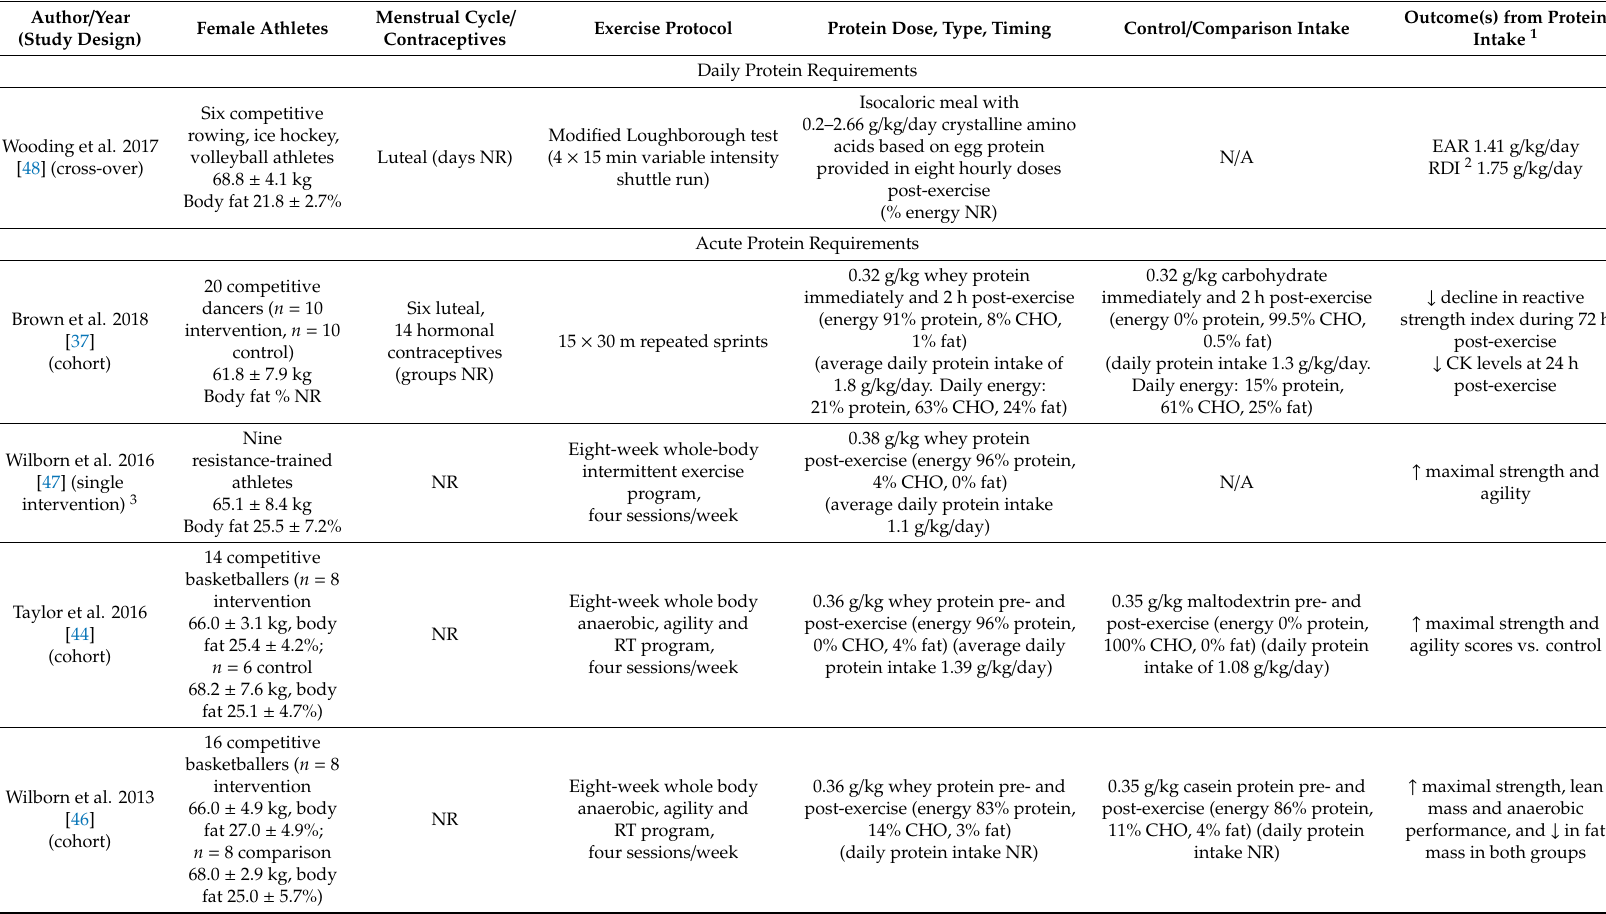
Table 4. Protein requirements of female athletes completing intermittent